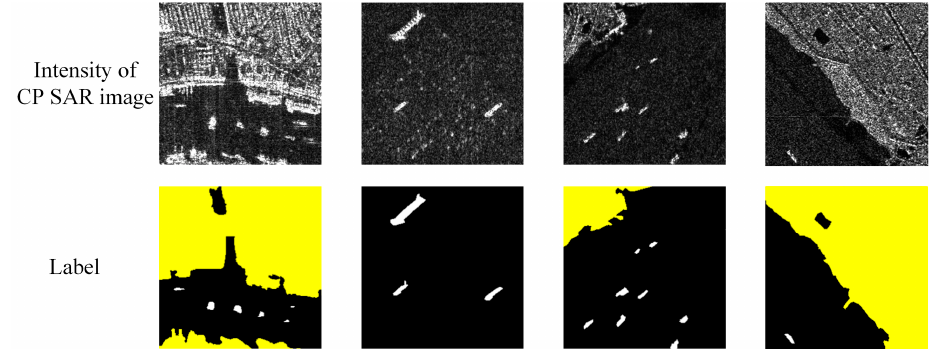
Figure 4. Illustrations of CP SAR images and corresponding label images. Land is yellow, ships are white, and the sea is black.